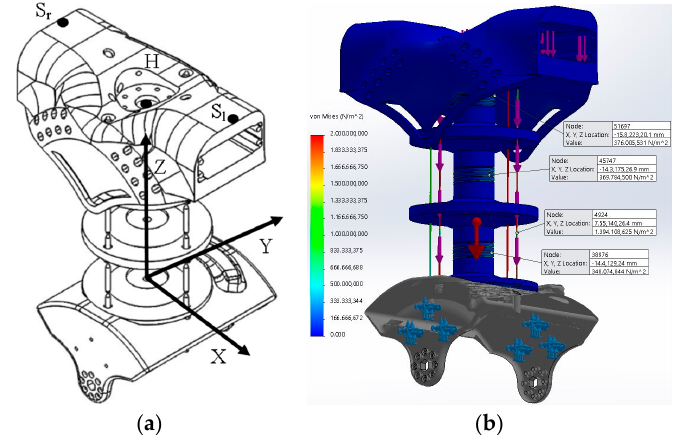
Figure 3. Mechanical design: ( a ) CAD model with characteristic points, ( b ) FEM computation results.